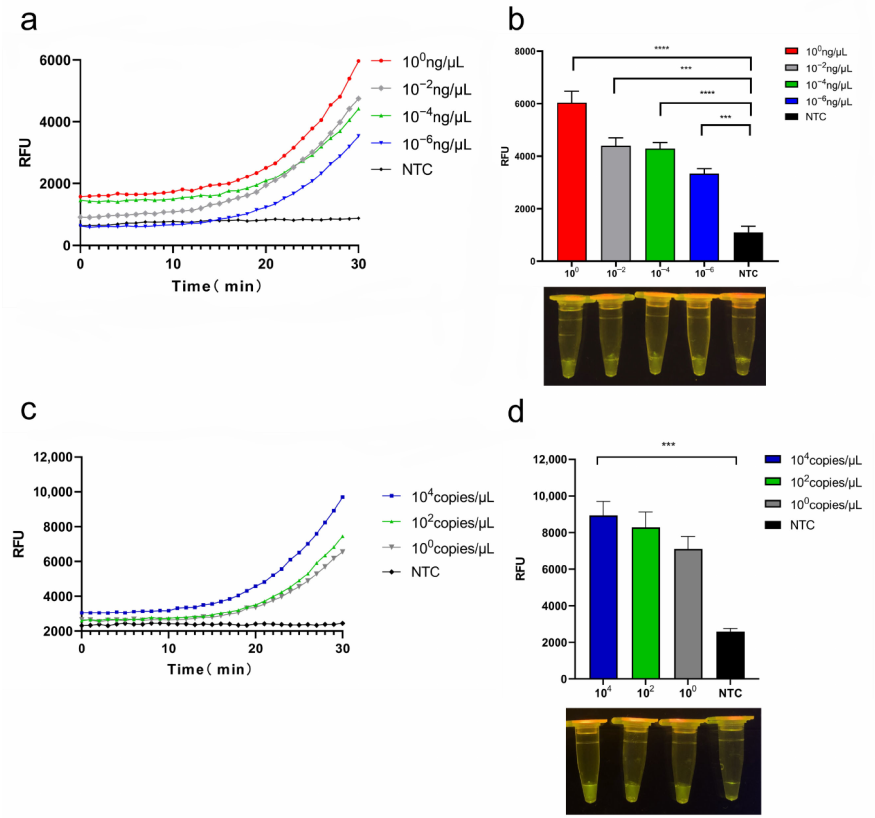
Figure 4. Sensitivity of the CRISPR/Cas12a system towards pathogenic Y. enterocolitica : ( a ) fluores- cence kinetic curves for crude genomic DNA; ( b ) endpoint fluorescence and visualization of results for crude genomic assay; ( c ) fluorescence kinetic curves of the recombinant plasmid pUC57- ail assay; ( d ) endpoint fluorescence and visualization results of the recombinant plasmid pUC57- ail assay. n = 3 biological replicates, * p < 0.05, ** p < 0.01, *** p < 0.001, and **** p < 0.0001, NTC—non-target control; error bars represent mean ±